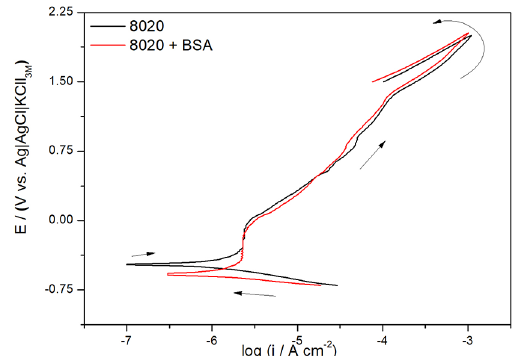
Figure 3. Cyclic polarization curves for the studied samples obtained in non-deaerated and unstirred Hanks' solution in the absence